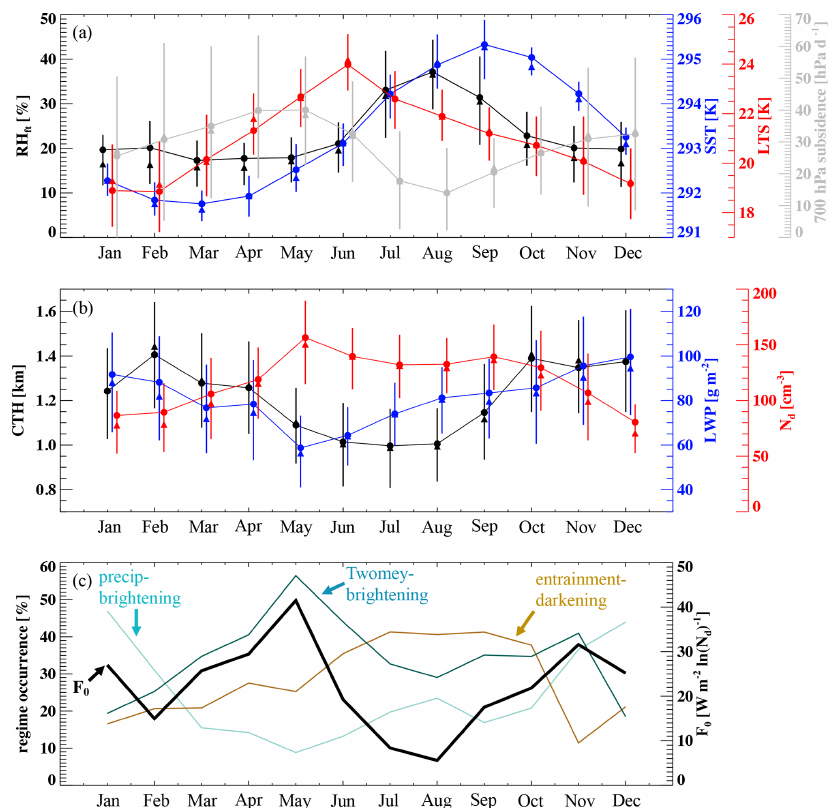
Figure 5. Annual cycle of (a) ERA5 RH ft (black), SST (blue), LTS (red), 700hPa subsidence (gray), (b) MODIS CTH (black), LWP (blue), and N d (red), as monthly means (filled circles), medians (filled triangles), and interquartile ranges (vertical bars). (c) Annual cycle of occurrence-weighted F 0 (black) and the occurrence of each albedo susceptibility regime